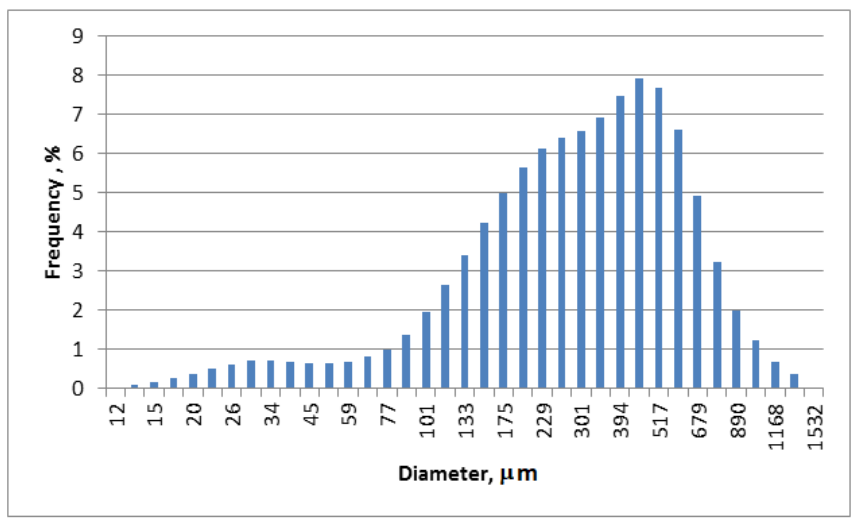
Figure 2. The particle size distribution of blackcurrant pomace (BCP).